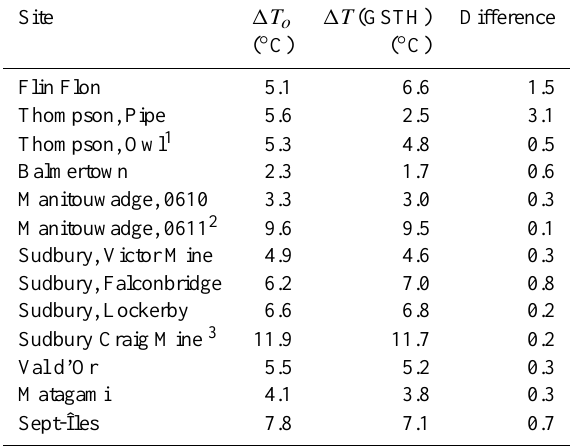
Table 4. Ranges in surface temperature variations estimated from the iteration of the long-term surface temperature as a function of depth (column 1) and from inversion of the GST history (column 2), along with the difference between the two (column